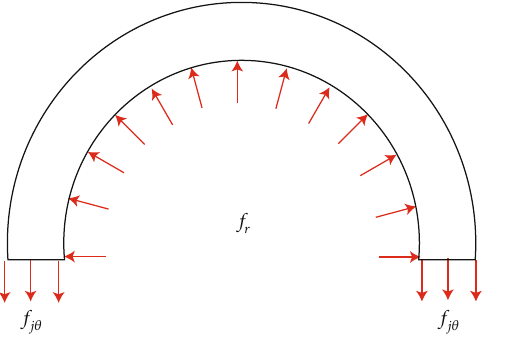
Figure 19: Restrained stress and circumferential stress of FRP